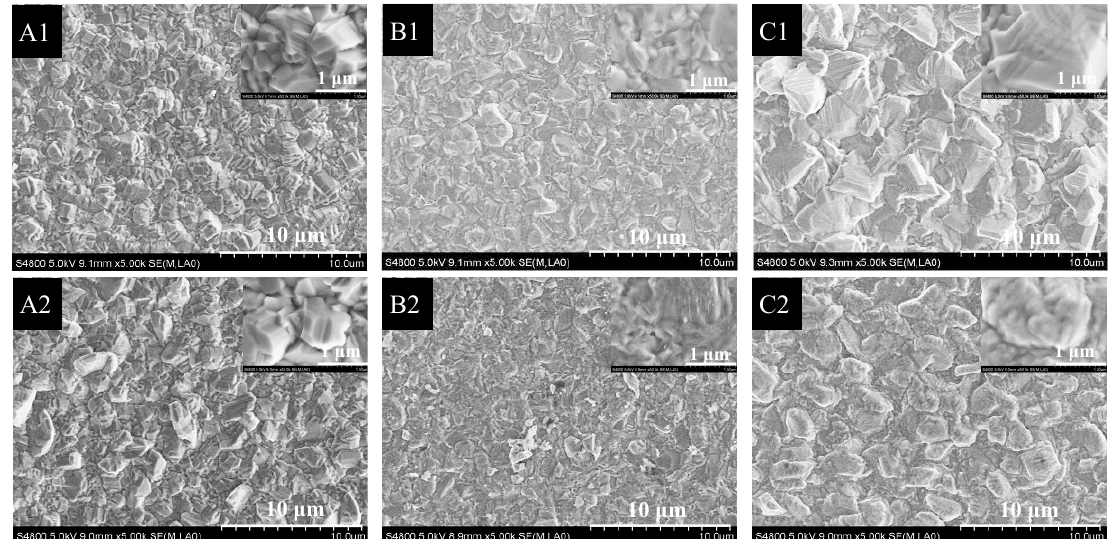
Fig. 5. SEM images of TiO 2 at 800 o C for 1.5 h under different flow rate of each component; A group is the Figure 5. SEM images of TiO 2 at 800 ◦ C for 1.5 h at di ff erent flow rate of each component; A group is